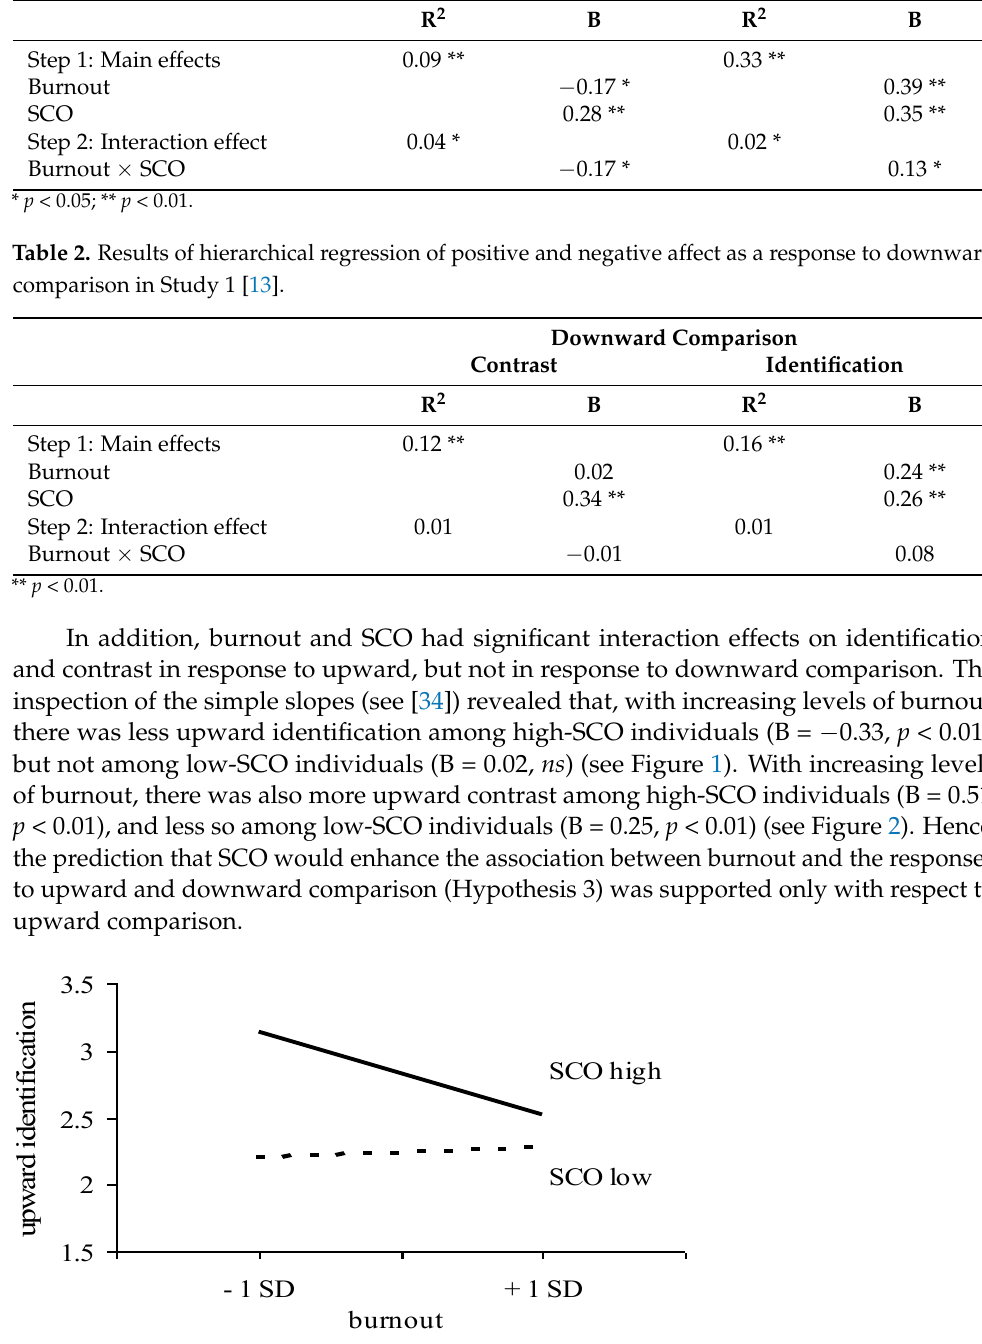
Figure 1. Upward identification as a function of burnout and SCO [13].